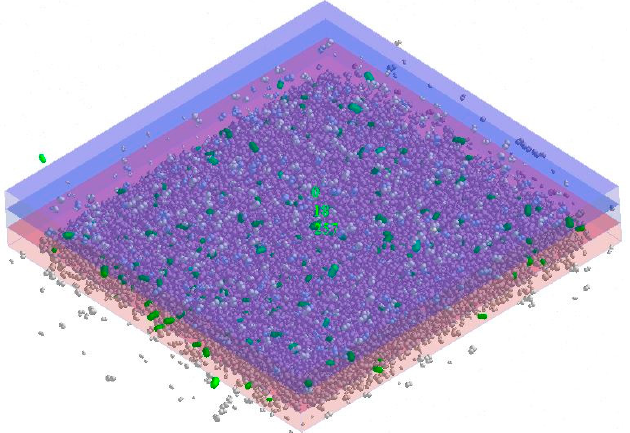
Figure 7. Three equally spaced grids (three layers) are set in the longitudinal direction (y direction). Equation (1) was used to calculate the standard deviation of the longitudinal num- ber of wheat: